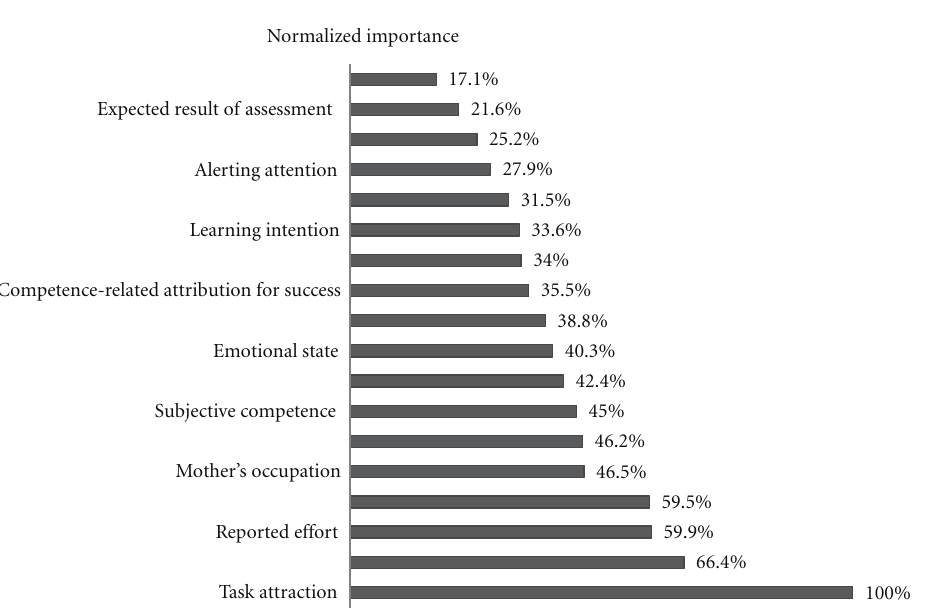
Figure 2: Normalized importance of the top variables participating in the model for the predictive classification of the highest 30% of scores in the mathematics test.